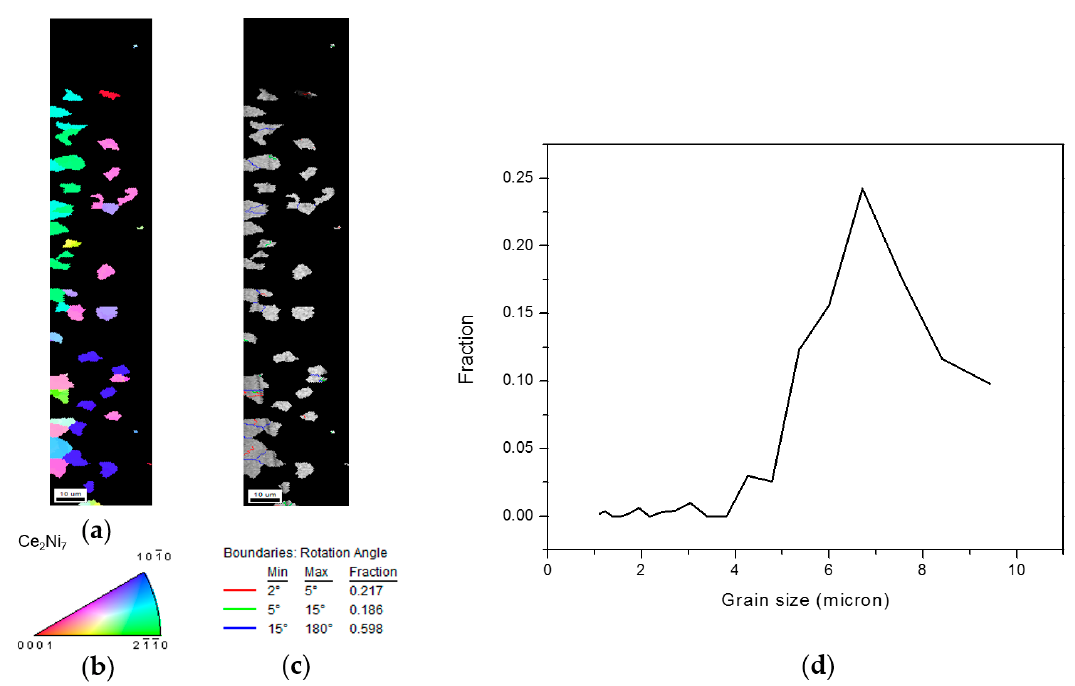
Figure 10. ( a ) IPF and EBSD mapping; ( b ) color assignment; ( c ) IQ diffraction pattern and grain boundary map; and ( d ) grain size distribution of the Ce 2 Ni 7 phase of the 16-h annealed sample.